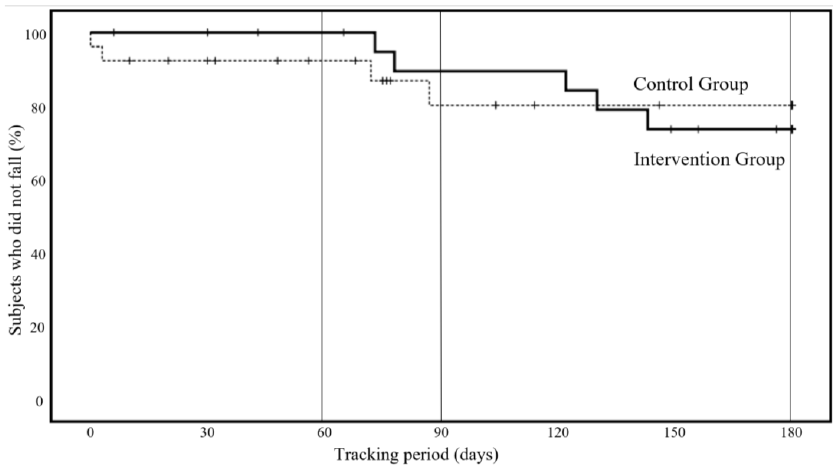
Figure 2. New occurrence of falls during the follow-up period (six months), Kaplan–Meier method. In the control group, two patients (7.7%) had fallen by the second month of the follow-up period, whereas in the intervention group, no falls were recorded during the same period. However, from the second month onward, falls were also noted in the intervention group. As a result of the log-rank test using the Kaplan – Meier method, no significant differences were noted between the two groups in the analysis up to the third ( p = 0.322, 95% confidence interval: 0.08 to 2.38) and sixth months ( p = 0.931, 95% confidence interval: 0.25 to 3.55). No injuries such as fractures due to falls were noted.